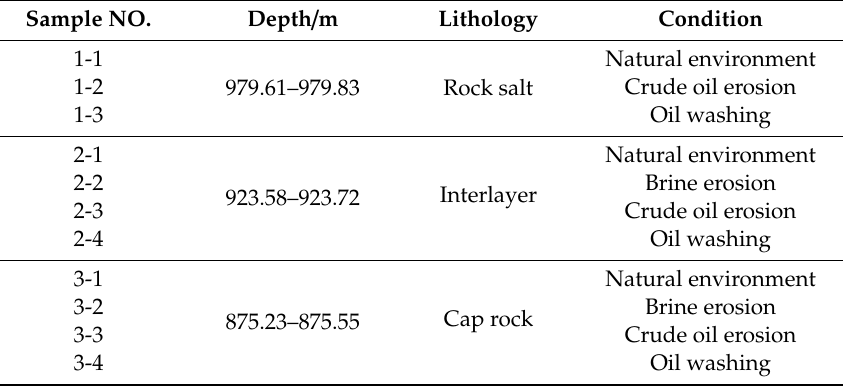
Table 6. Basic information about test samples and test conditions.